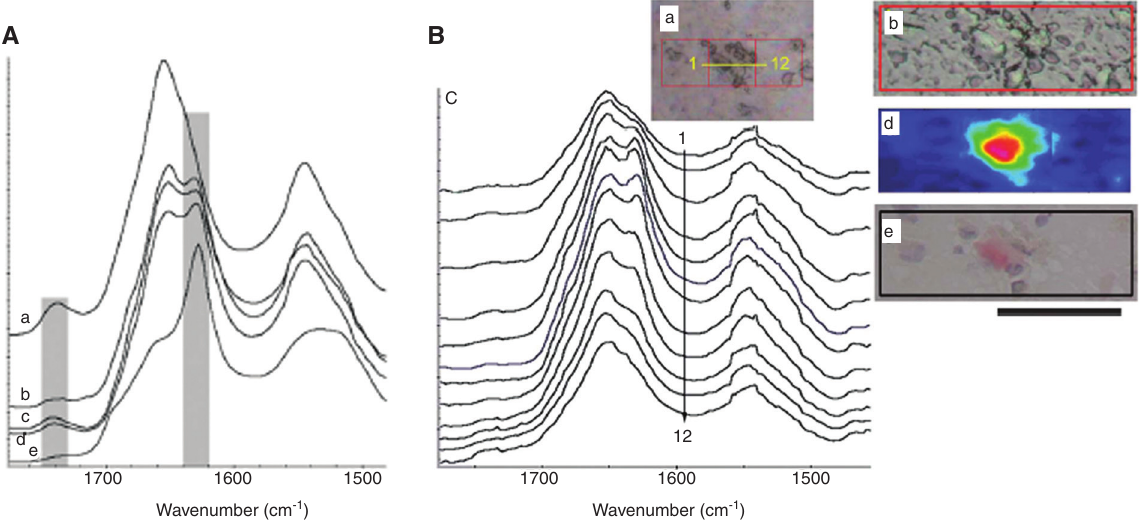
Figure 1 Synchrotron-FTIR analysis of senile plaques in human and transgenic mouse AD brain. (A) Amide-I and -II regions from (a) mouse grey matter, (b) human plaque core, (c) TgCRND8 mouse plaque core, (d) 3xTg mouse plaque core, and (e) fibrillar A β 42. The CO stretch peak and the β -sheet peak in the amide-I band are highlighted with a gray box. With the exception of (e), spectra are displayed on a common scale, offset for clarity. (B) Amide-I and -II regions and images of dense core hippocampus plaque from a 91-year-old AD patient. (a) Images viewed through FTIR microscope. (b) Images viewed through light microscope. (c) Stack of 12 spectra spanning the plaque and extracted from image along yellow line in (a). (d) False-color images of the 3 × 1 tile mosaic treated to show amide-I band intensity due to β -sheet. Color indicates low (blue) to high (red) content in β -sheet. (e) Photograph of tissue stained after FTIR imaging: plaque core is stained red by Congo red and nuclei blue by hematoxylin. Scale bar, 50 μ m. Reproduced and adapted from Liao et al.